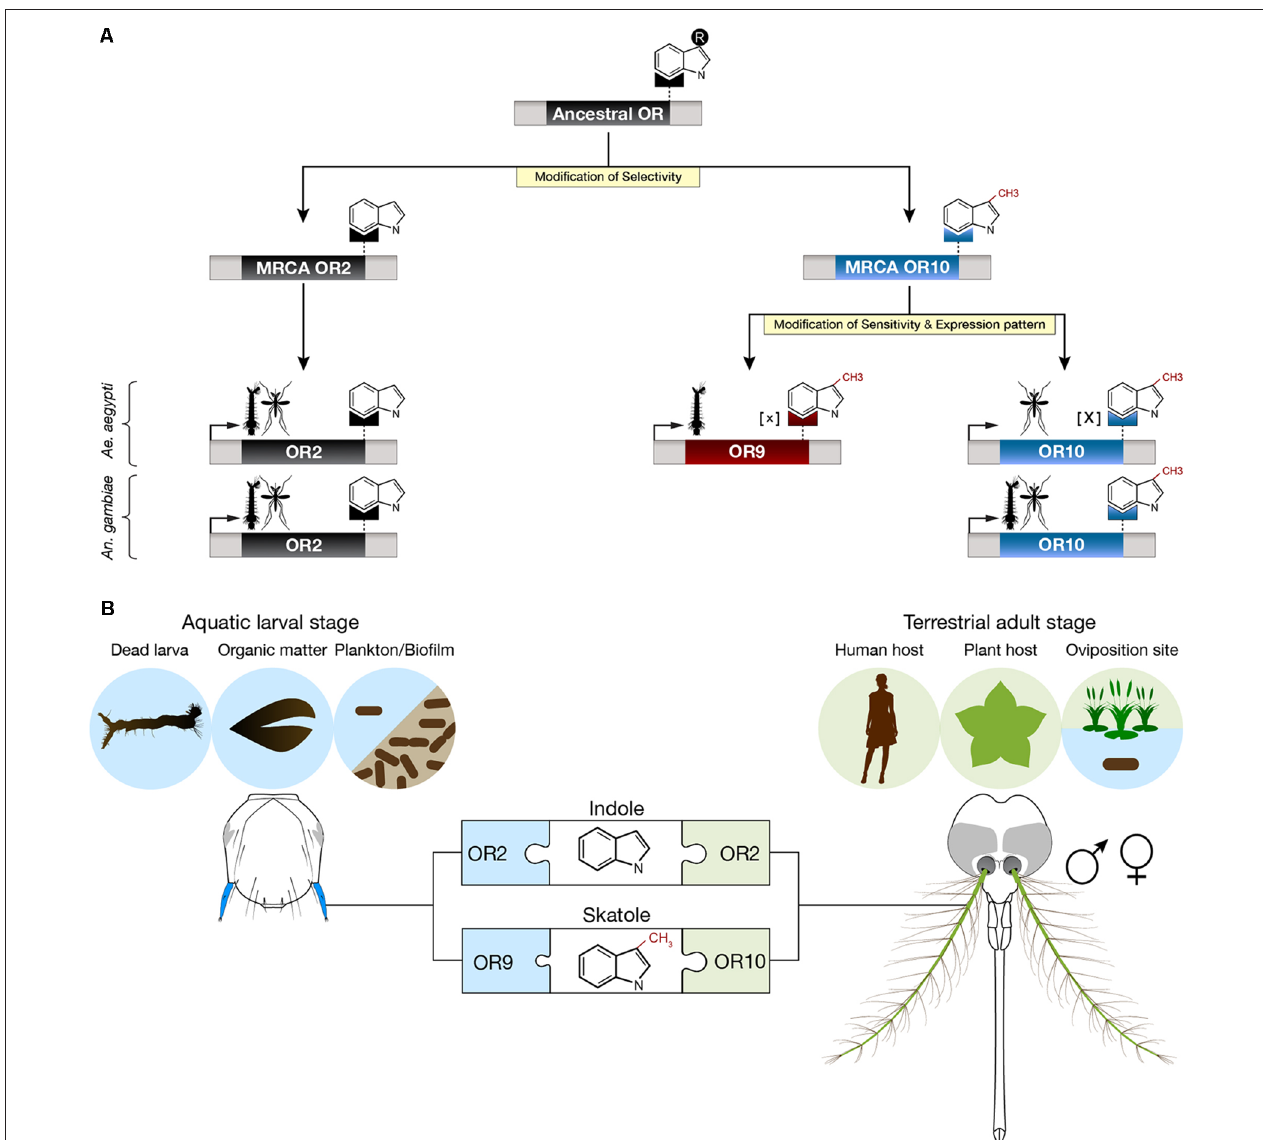
FIGURE 4 | Proposed evolution and ecological roles of Aedes aegypti indolergic receptors. (A) The Or2 , 9 and 10 gene clade derives from two successive gene duplication events followed by neofunctionalization (yellow highlights) consisting of modifications of ligand selectivity, sensitivity and developmental expression patterns. The most parsimonious hypothesis is that the most recent common ancestors (MRCAs) of Or2 and Or10 derived from a gene duplication event prior to the Anophelinae-Culicinae split. This event lead to neofunctionalization by means of selective detection of indole derivatives. The second duplication event arose in the Culicinae subfamily (e.g., Ae. aegypti ) leading to the emergence of a low [X] and high [x] sensitivity skatole receptor, each expressed in a distinct developmental stage. (B) Putative ecological roles of indole and skatole in adults and larvae. Adults may detect both indole compounds to identify suitable hosts and oviposition sites while larvae may use these compounds to locate food sources, including dead larvae, decomposing organic matter and